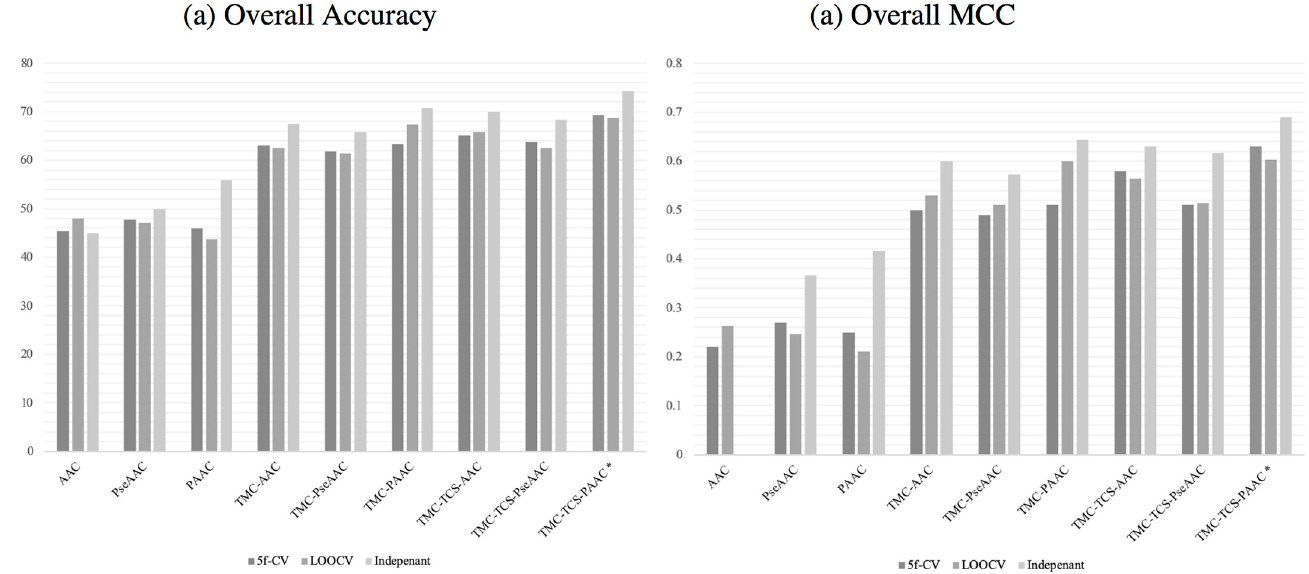
Fig 3. Methods overall performance. (a) overall accuracy, and (b) overall MCC. The asterisk ( � ) symbol refers to the performance of TranCEP, which is TCS-TMC-PAAC.